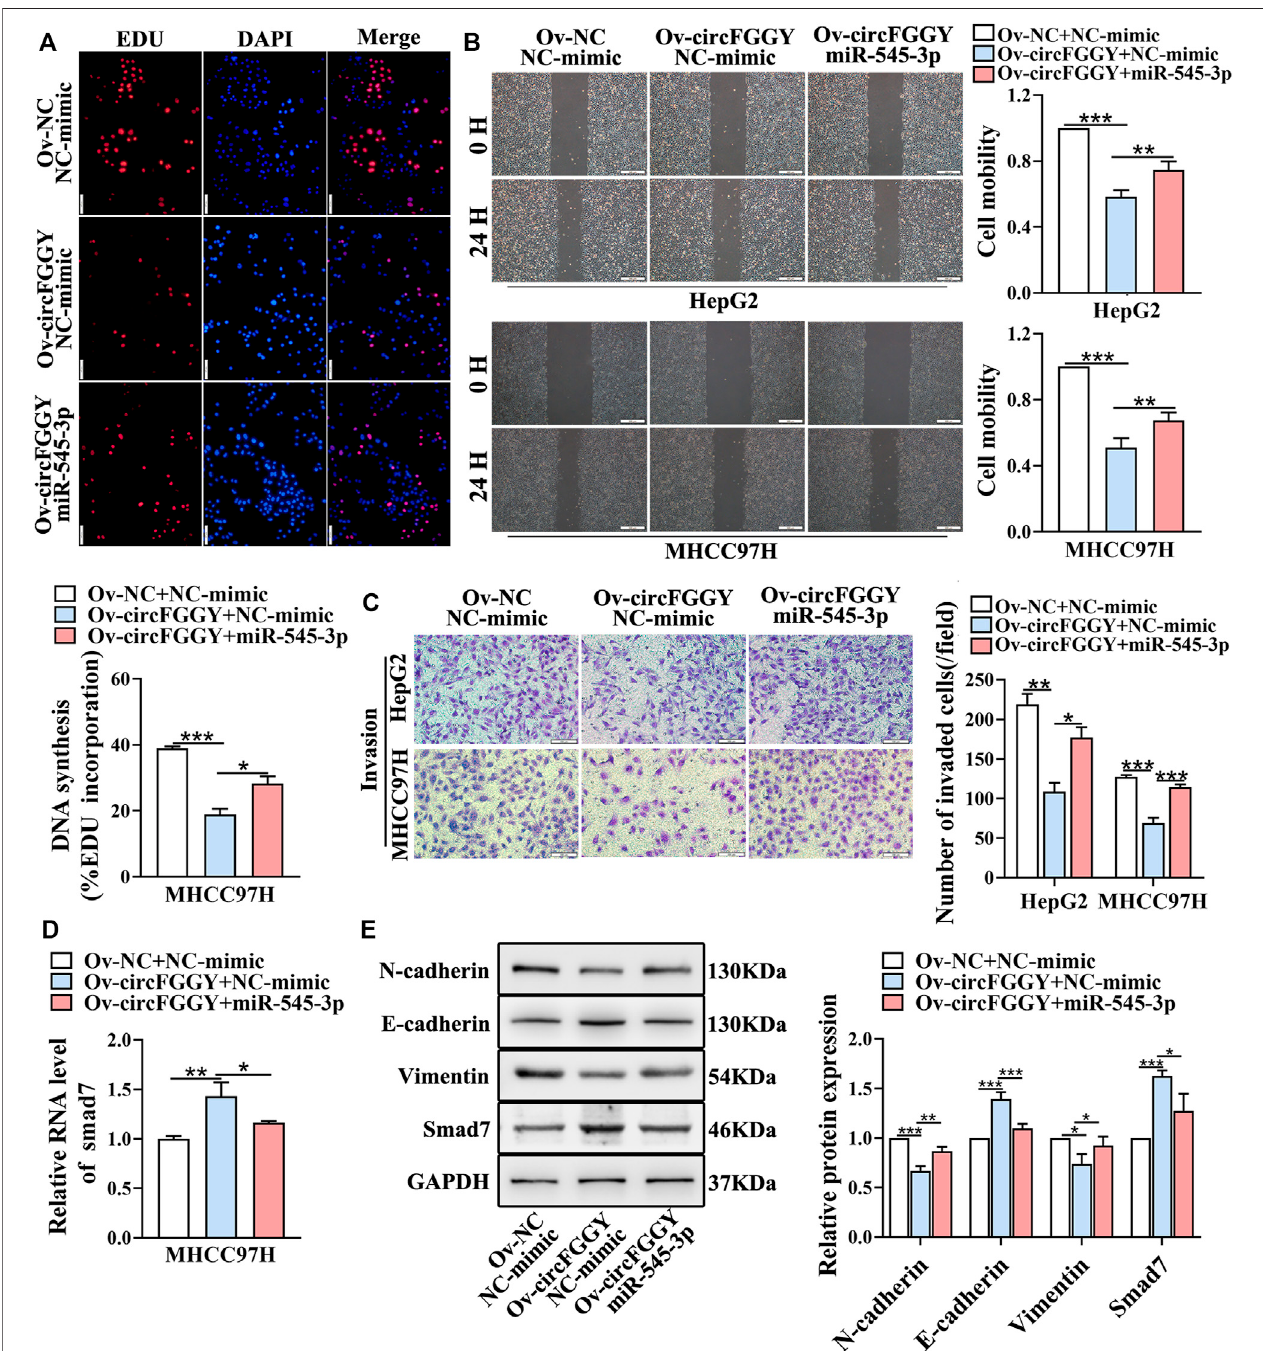
FIGURE 6 | CircFGGY inhibits the growth and metastasis of HCC through the miR-545-3p/Smad7 axis in vitro . (A – C) The cell proliferation (A) , migration (B) and invasion (C) decreased after the overexpression of circFGGY, and these processes were reversed after overexpression of miR-545-3p in MHCC97H or HepG2 cells. Scale bar, 500 µm (B) , 100 µm (A,C) . (D) The mRNA expression of Smad7 was upregulated after overexpression of circFGGY, and the expression was reversed after overexpressionofmiR-545-3pinMHCC97Hcells. (E) WesternblotdetectedtheproteinexpressionofSmad7andthebiomarkersofEMTaftertheoverexpression ofcircFGGYorcircFGGY/miR-545-3pinMHCC97Hcells.One-WayANOVAwasused (A – E) .Dataarerepresented asmean±SD, n =3.ComparingwithOv-circFGGY + NC-mimic group, *: p < 0.05; **: p < 0.01; ***: p < 0.001.